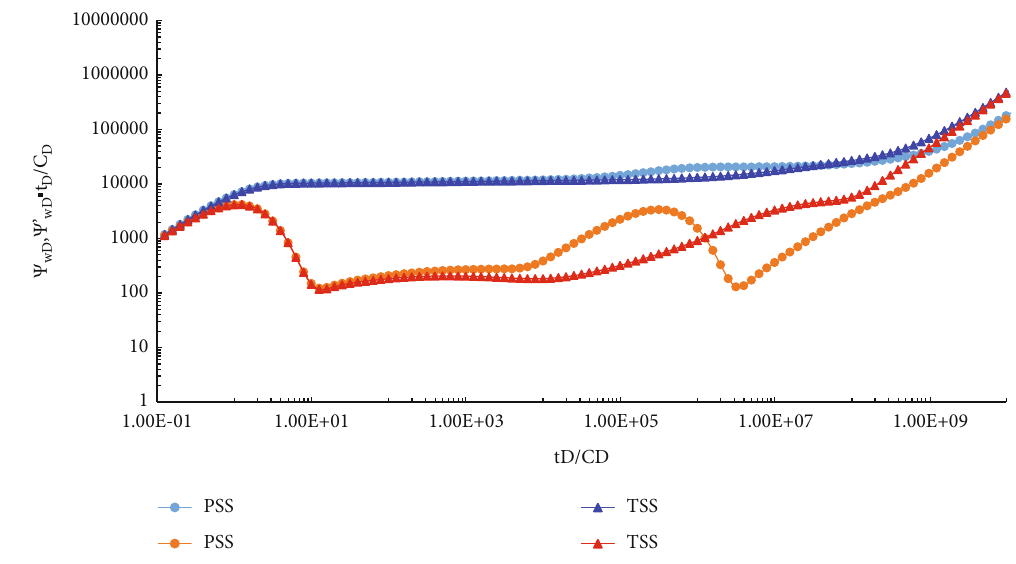
Figure 11: Comparison with the transient steady-state and pseudosteady-state models. Table 3: Basic data of production